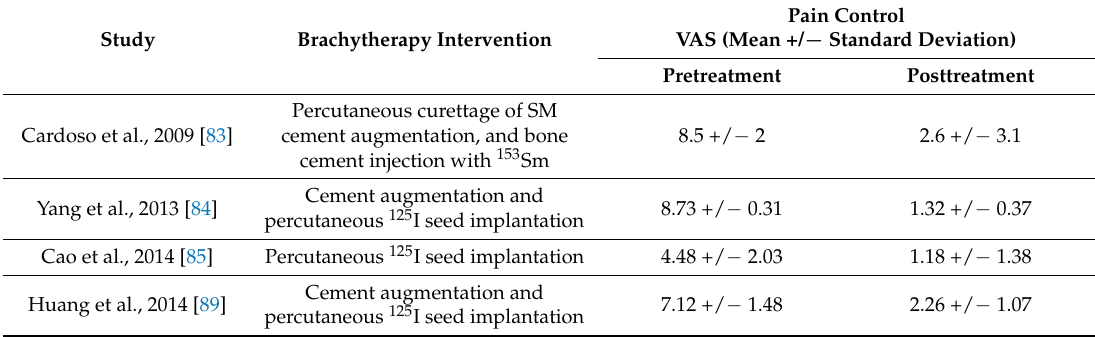
Table 4. Influence of brachytherapy on pain control in painful spine tumours [83–89]. 125